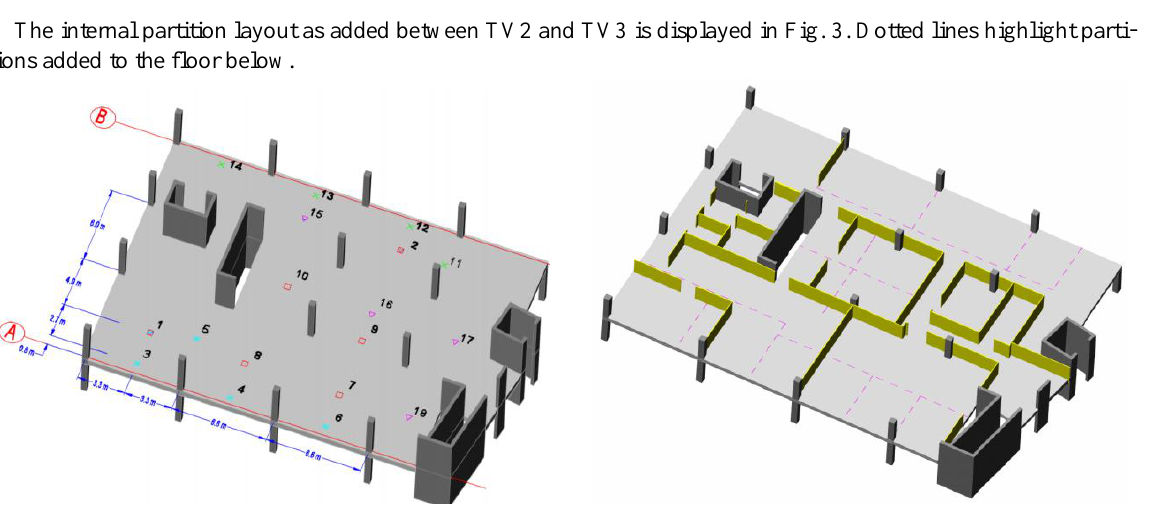
Fig. 2. Sensor locations: 1−18. Fig. 3. First floor internal partition